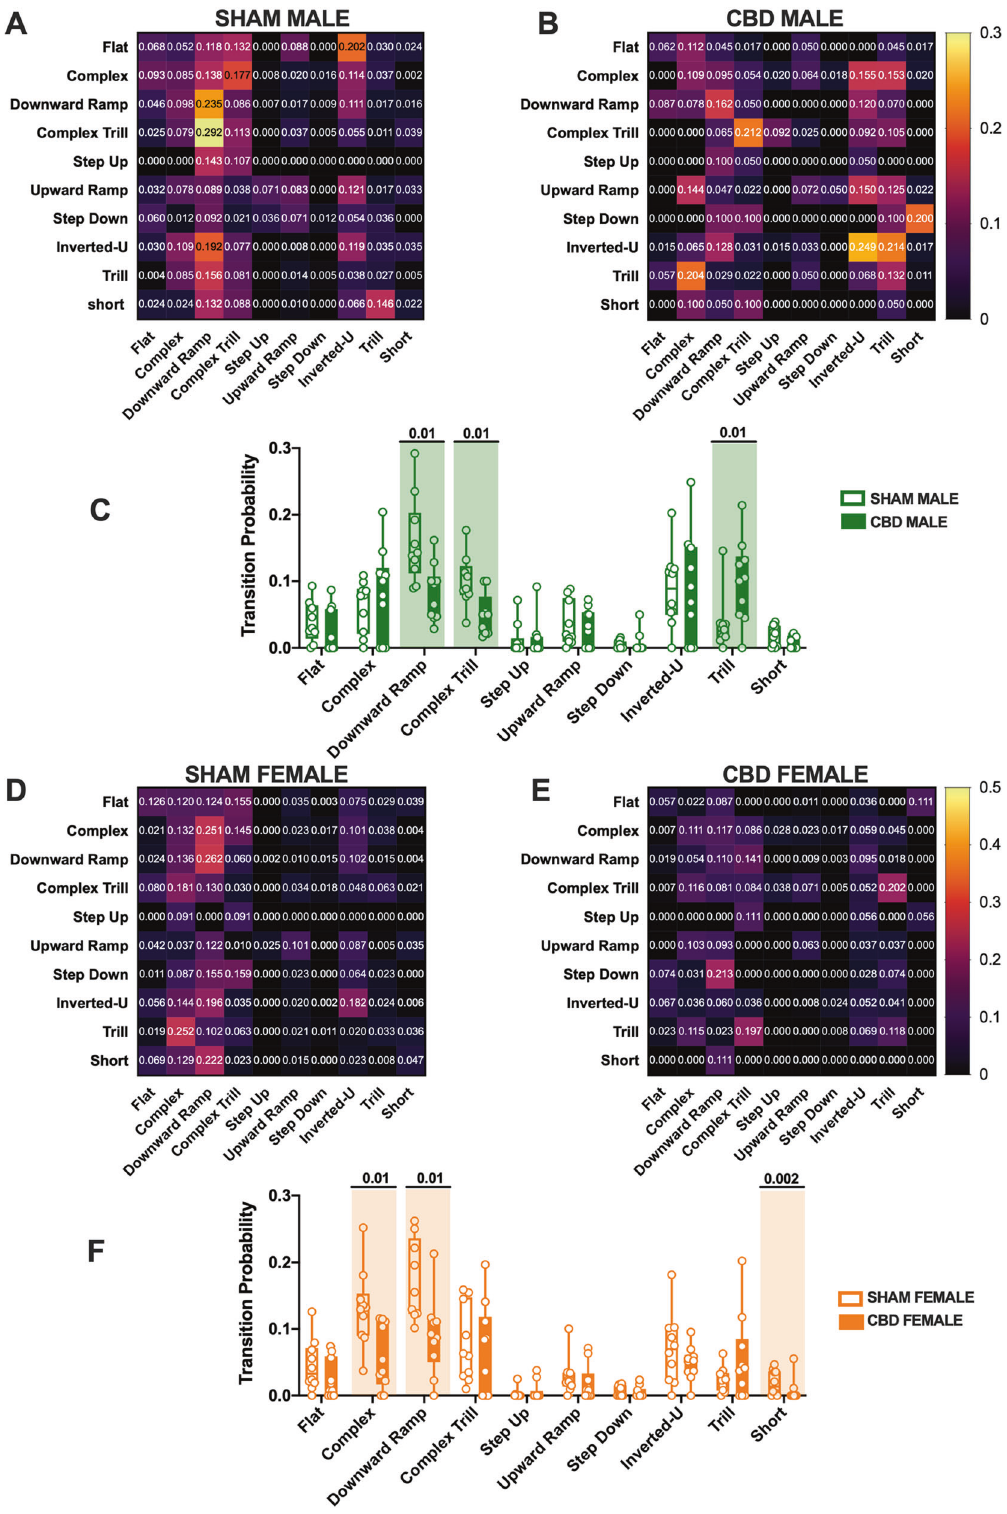
Fig. 4 Transitional probabilities for call type transitions within USV bouts in SHAM and CBD pups. Heat maps of transition probabilities in SHAM ( A ) and CBD male ( B ) as well as in SHAM ( D ) and CBD female ( E ) pups. The values in the individual boxes indicate the probability of one call to follow the previous ( A , B – E ). The transitional probability was expressed as the mean probability of each transition for each subject. C The comparison of transitional probabilities shows that CBD-exposed male transitioned signi fi cantly less to Downward Ramp and Complex Trill calls than SHAM male pups and that CBD male transitioned more to Trill than SHAM. F CBD females showed a lower probability to transition to Complex, Downward Ramp and Short calls. Data are represented as Box and whisker plots ( fi rst quartile, median, third quartile). Individual data points represent the transitional probabilities of calls emitted by each group. SHAM MALE N = 14, CBD MALE N = 7, SHAM FEMALE N = 11, CBD FEMALE N = 11. Multiple Mann – Whitney U test, * p <